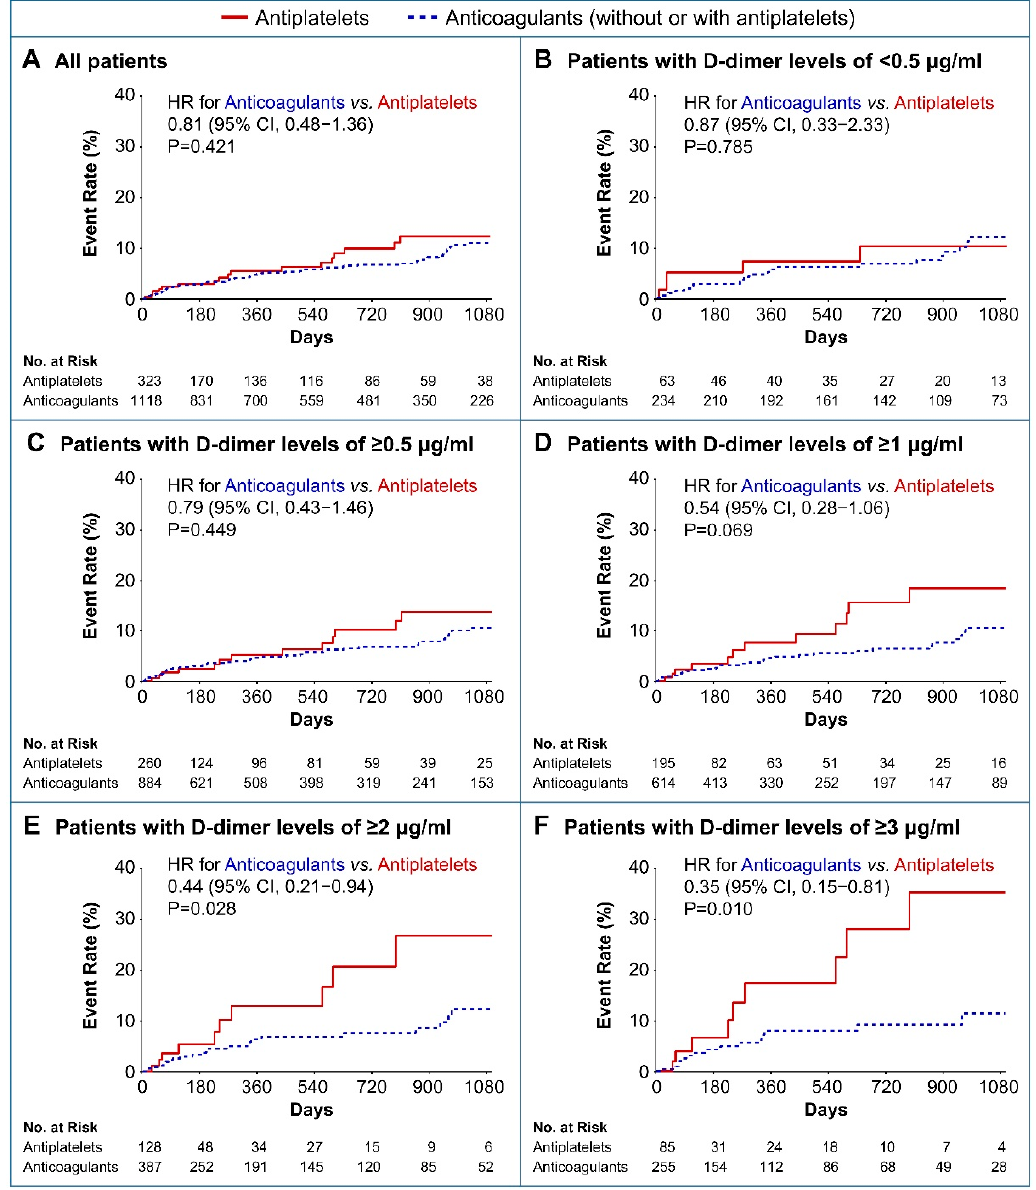
Figure 4. Kaplan–Meier curves for recurrent ischemic stroke according to antithrombotic therapy according to the baseline D-dimer levels. HR, hazard ratio; CI, confidence interval.